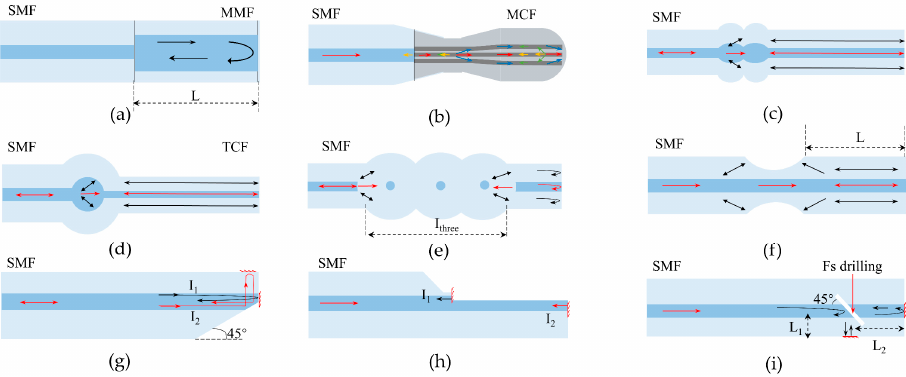
Figure 7. Typical types of MI sensors for high-temperature measurements realized with core diam-